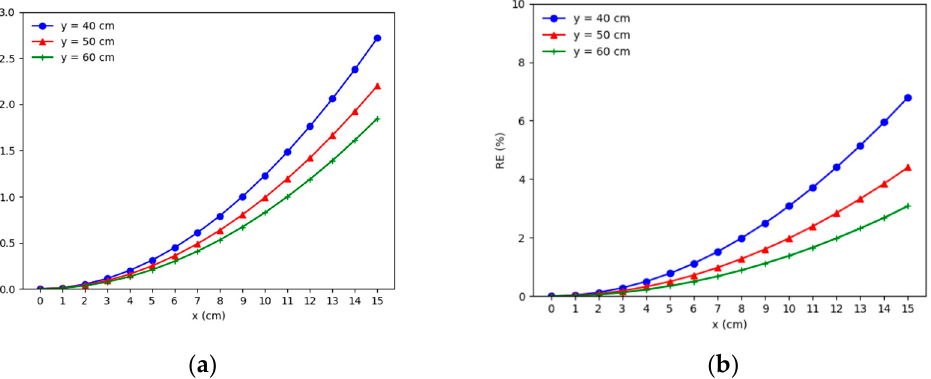
Figure 3. Error of the distance approximation method: ( a ) Absolute error; ( b ) Relative error.